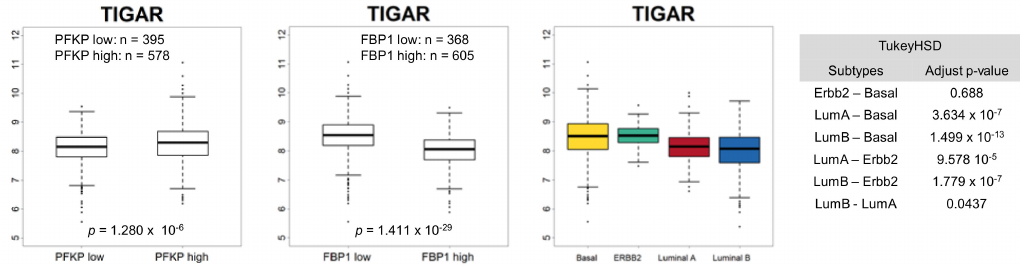
Figure 4. TIGAR is increased in FBP1-loss basal-like subtype of breast cancer. Comparison of TIGAR transcript levels according to PFKP (left panel), FBP1 (middle panel), and breast cancer subtypes (right panels). TIGAR expression was significantly higher in PFKP high, FBP1 low subsets, and basal-like subtype. Statistical significance was determined by Tukey’s HSD (honestly significant di ff erence)